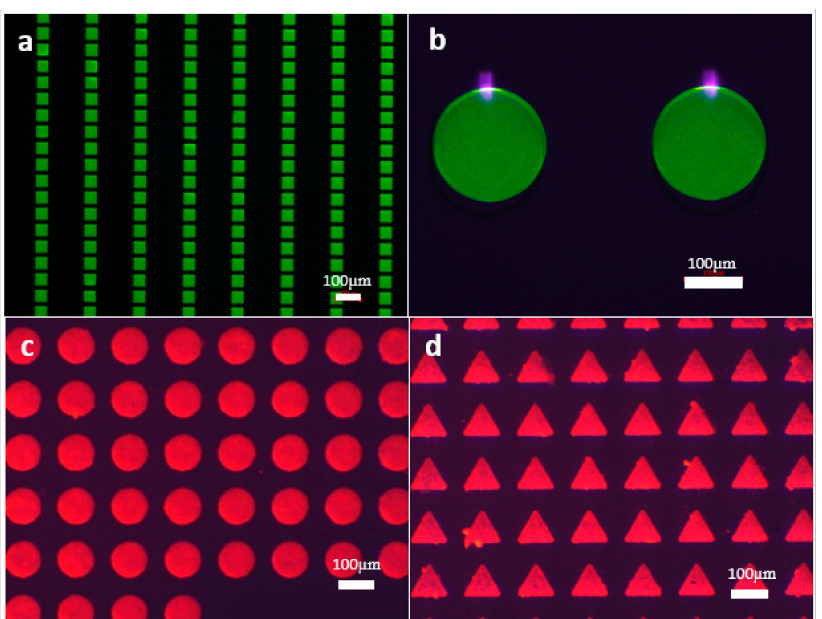
Figure 4. ( a ) 50 µ m epoxied green QDs pixel in a large area; ( b ) epoxied green QDCF patterns with good uniformity; ( c ) 100 µ m epoxied red QDCF pixel; ( d ) pristine red QDCF pixel. Blue light with a wavelength of 450 nm was used to excite QD films.